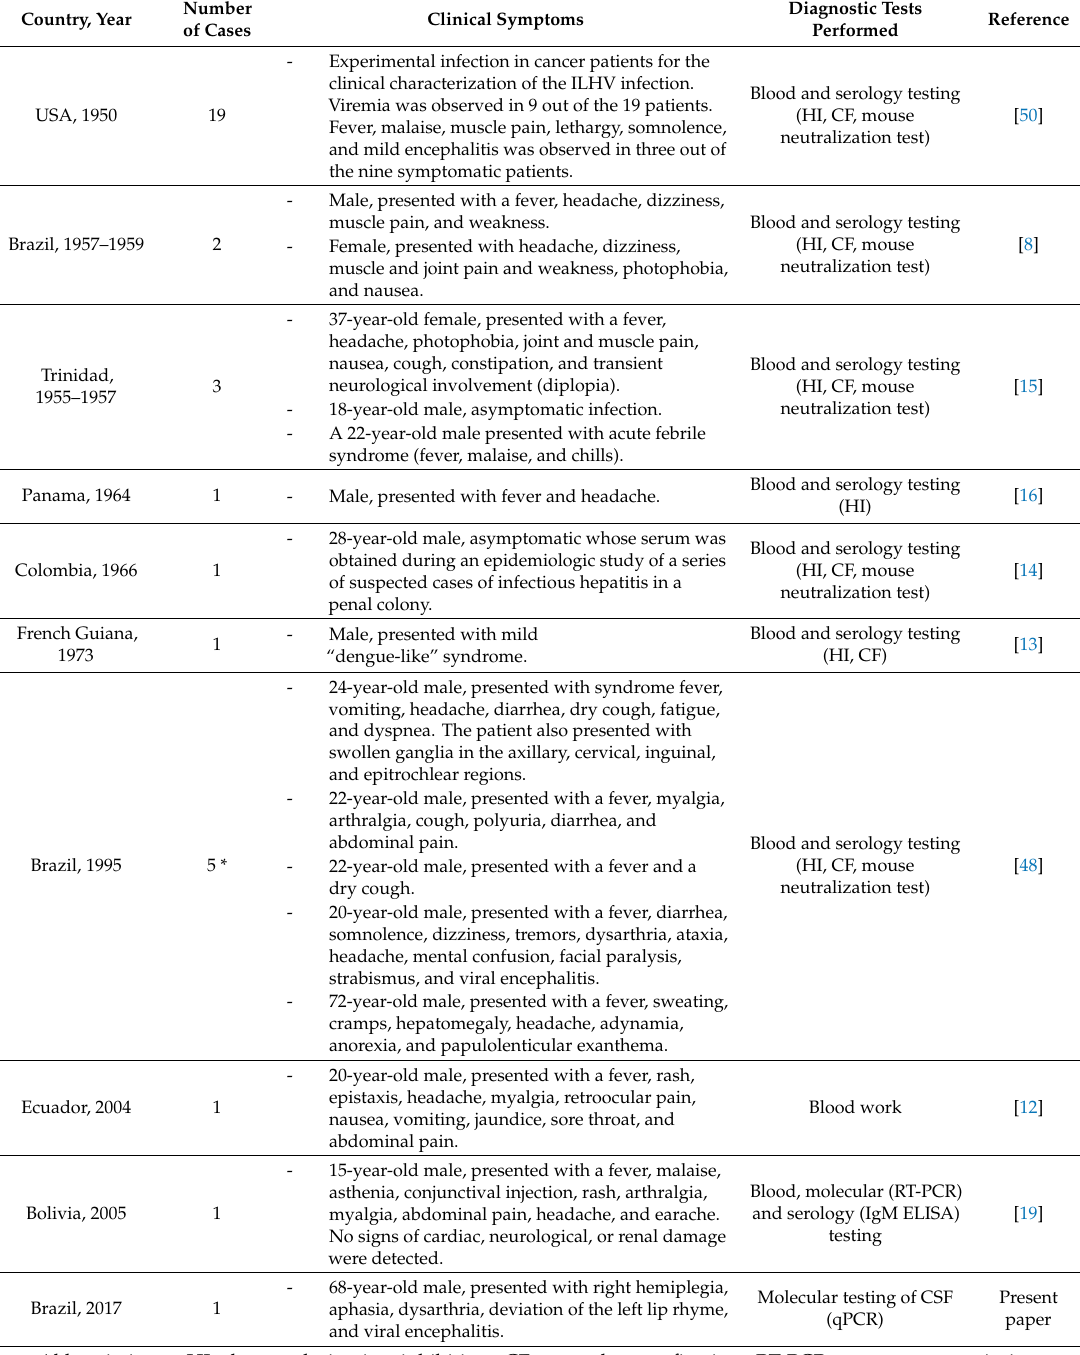
Table 1. Clinical symptoms that were observed in documented ILHV human